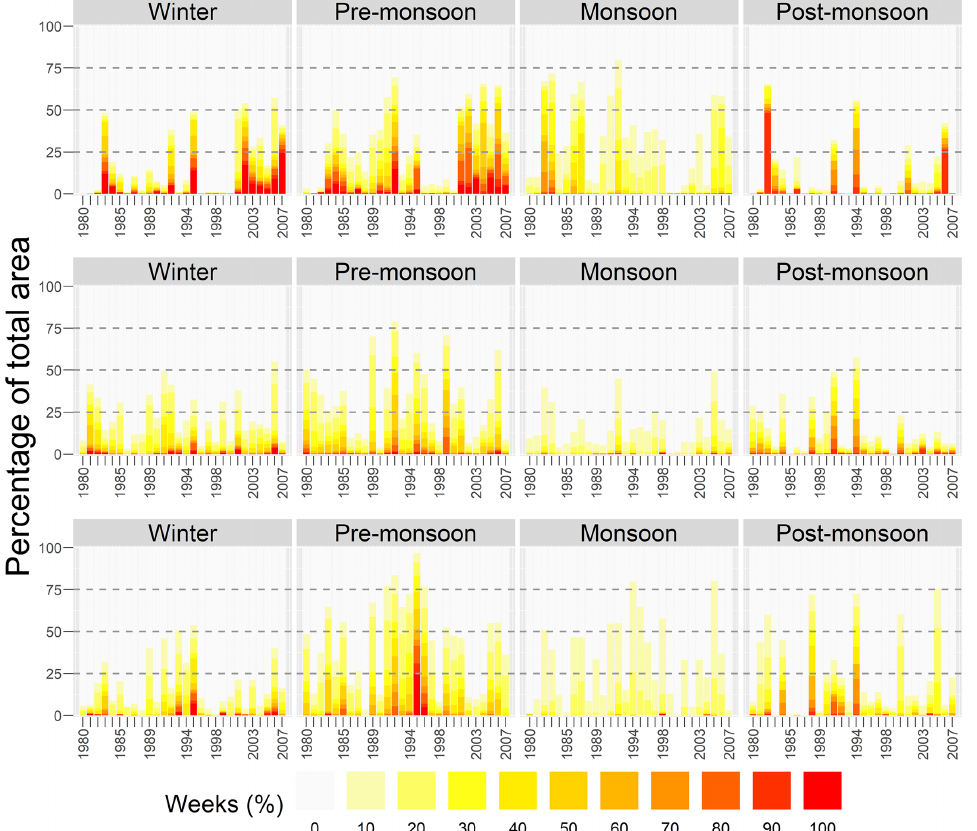
Figure 12. Percentage of weeks with severe drought in the trans-Himalaya (top row), the mountains (middle row), and the plains (bottom row). Note: each colour band shows the respective HRU areas